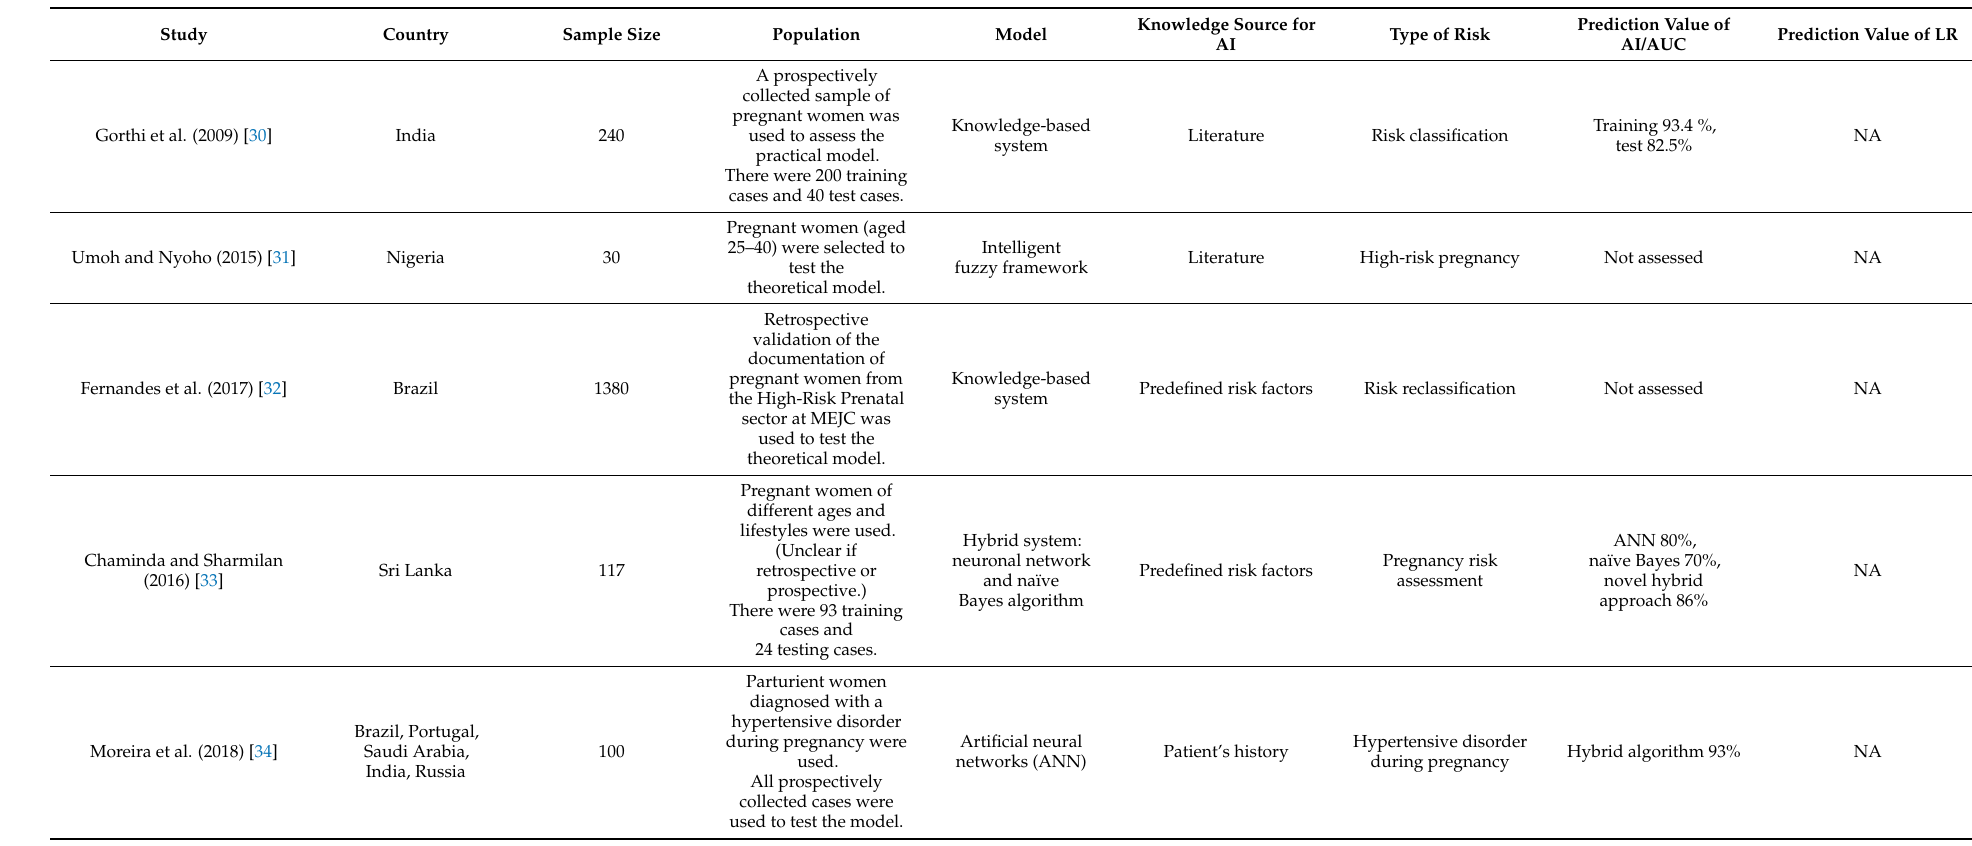
Table 2. Characteristics of included studies on general pregnancy risk